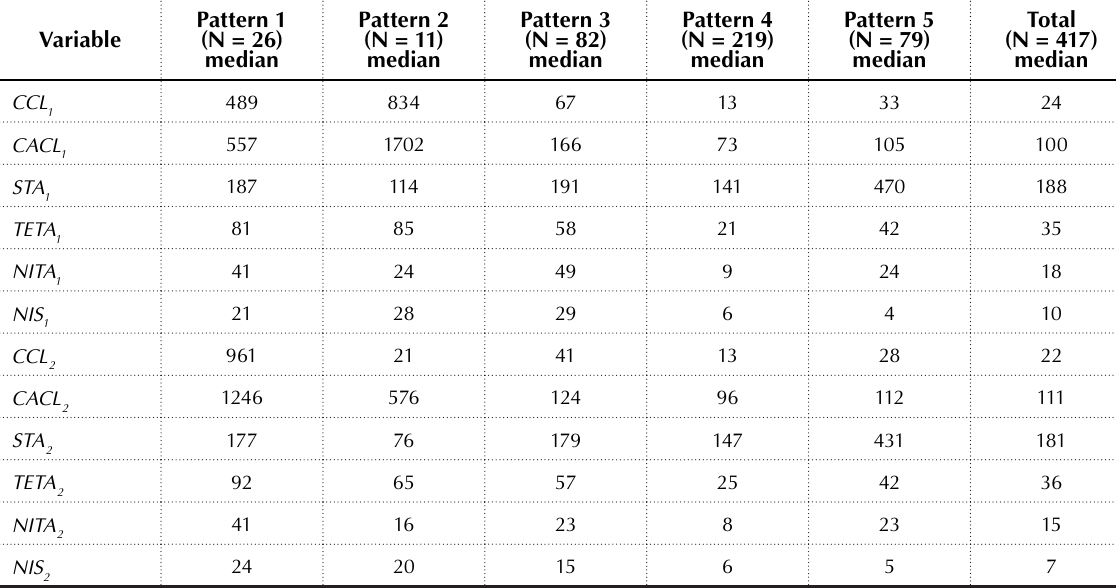
Table 6. Contingency between detected patterns and firm statuses